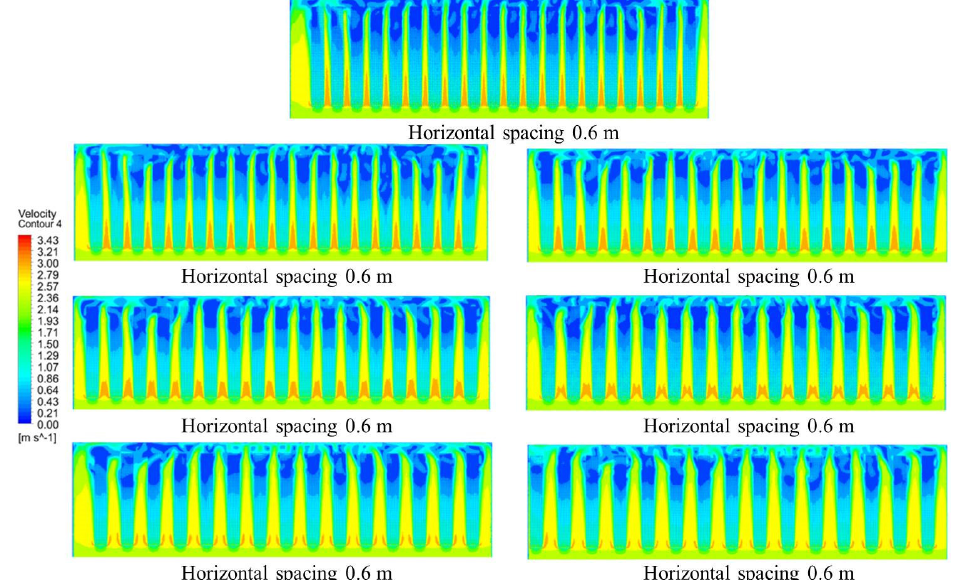
Figure 9. Velocity distributions of typical cross sections under the different horizontal spacings of cultivation racks.